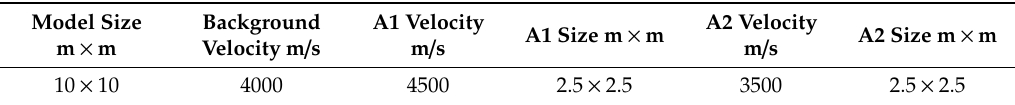
Table 1. Parameters of sound field model.